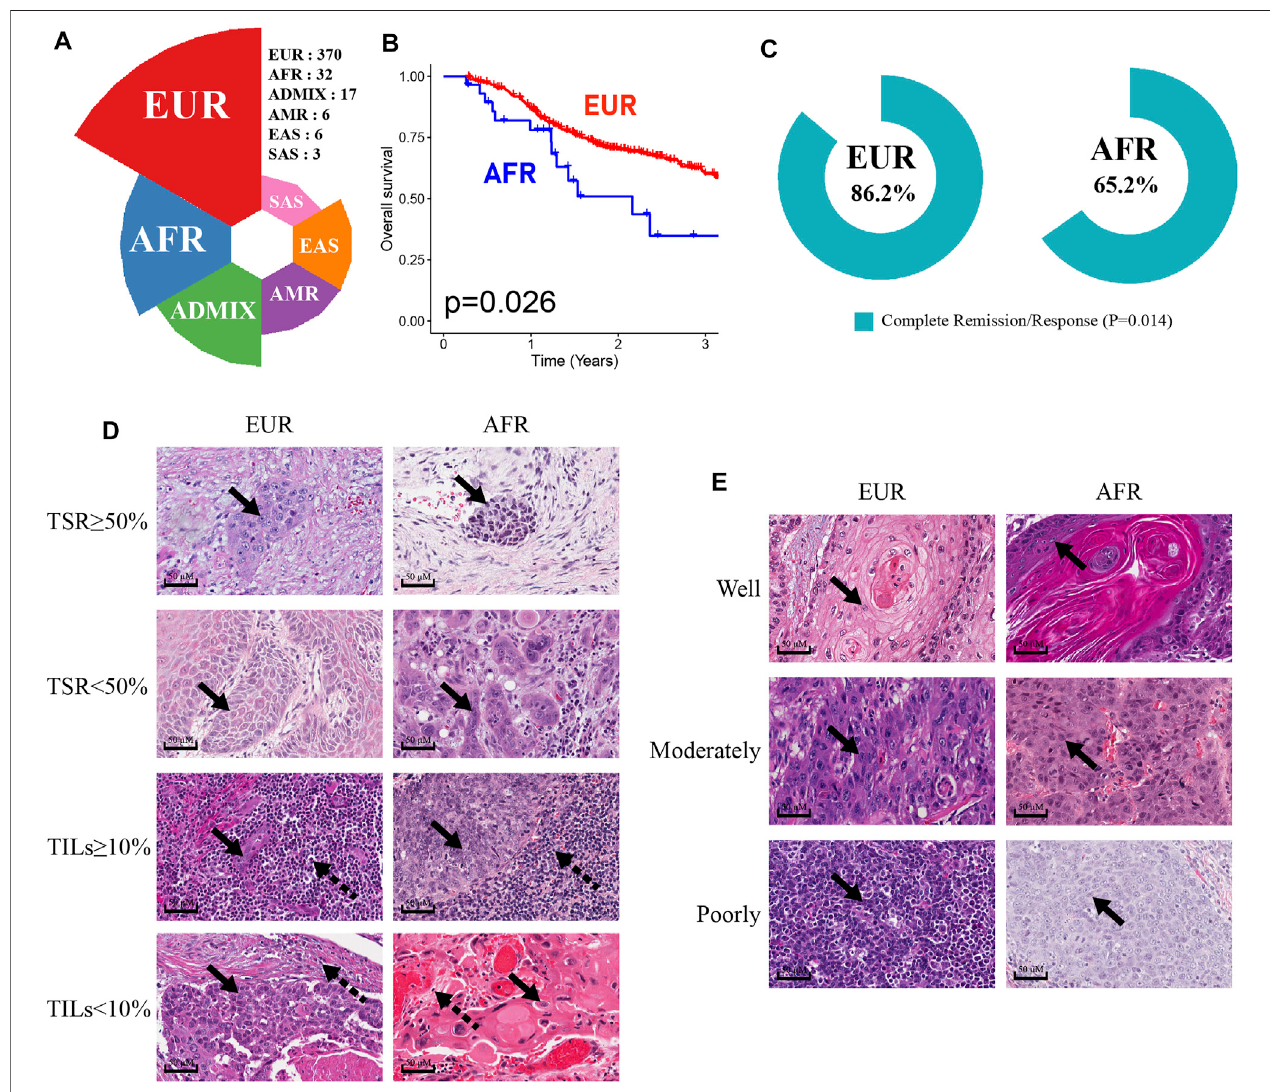
FIGURE2| Characteristics of OSCC patients of EUR or AFR genetic ancestry. (A) The percentage of OSCC patients with different genetic ancestries in the TCGA database. (B) The OS of patients of AFR ancestry was signi fi cantly lower than that of patients of EUR ancestry. (C) The complete remission rates of patients of EUR and AFR ancestries following initial treatment were signi fi cantly different. (D) The results of HE staining were used to divide EUR and AFR ancestry patients into TSR ≥ 50% and TSR < 50% groups and TILs ≥ 10% and TILs < 10% groups (scale bar: 50 μ M, magni fi cation: 40X; the solid arrowhead indicates tumor cells, and the dotted arrowhead indicates lymphocytes). (E) HE staining results were used to divide EUR and AFR ancestry patients into well differentiated, moderately differentiated, and poorly differentiated tumor groups (scale bar: 50 μ M, magni fi cation: 40X; the solid arrowhead indicates tumor